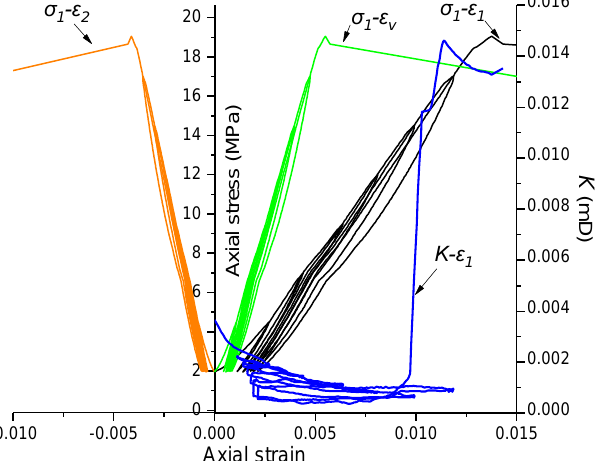
Figure 8. The relationships among the stress, strain, and permeability of raw coal under stress path 2.